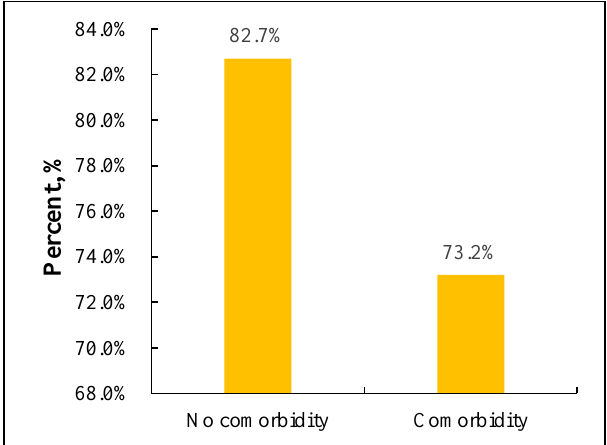
Figure 1. Willingness to accept the booster dose of COVID-19 vaccine, N = 410.